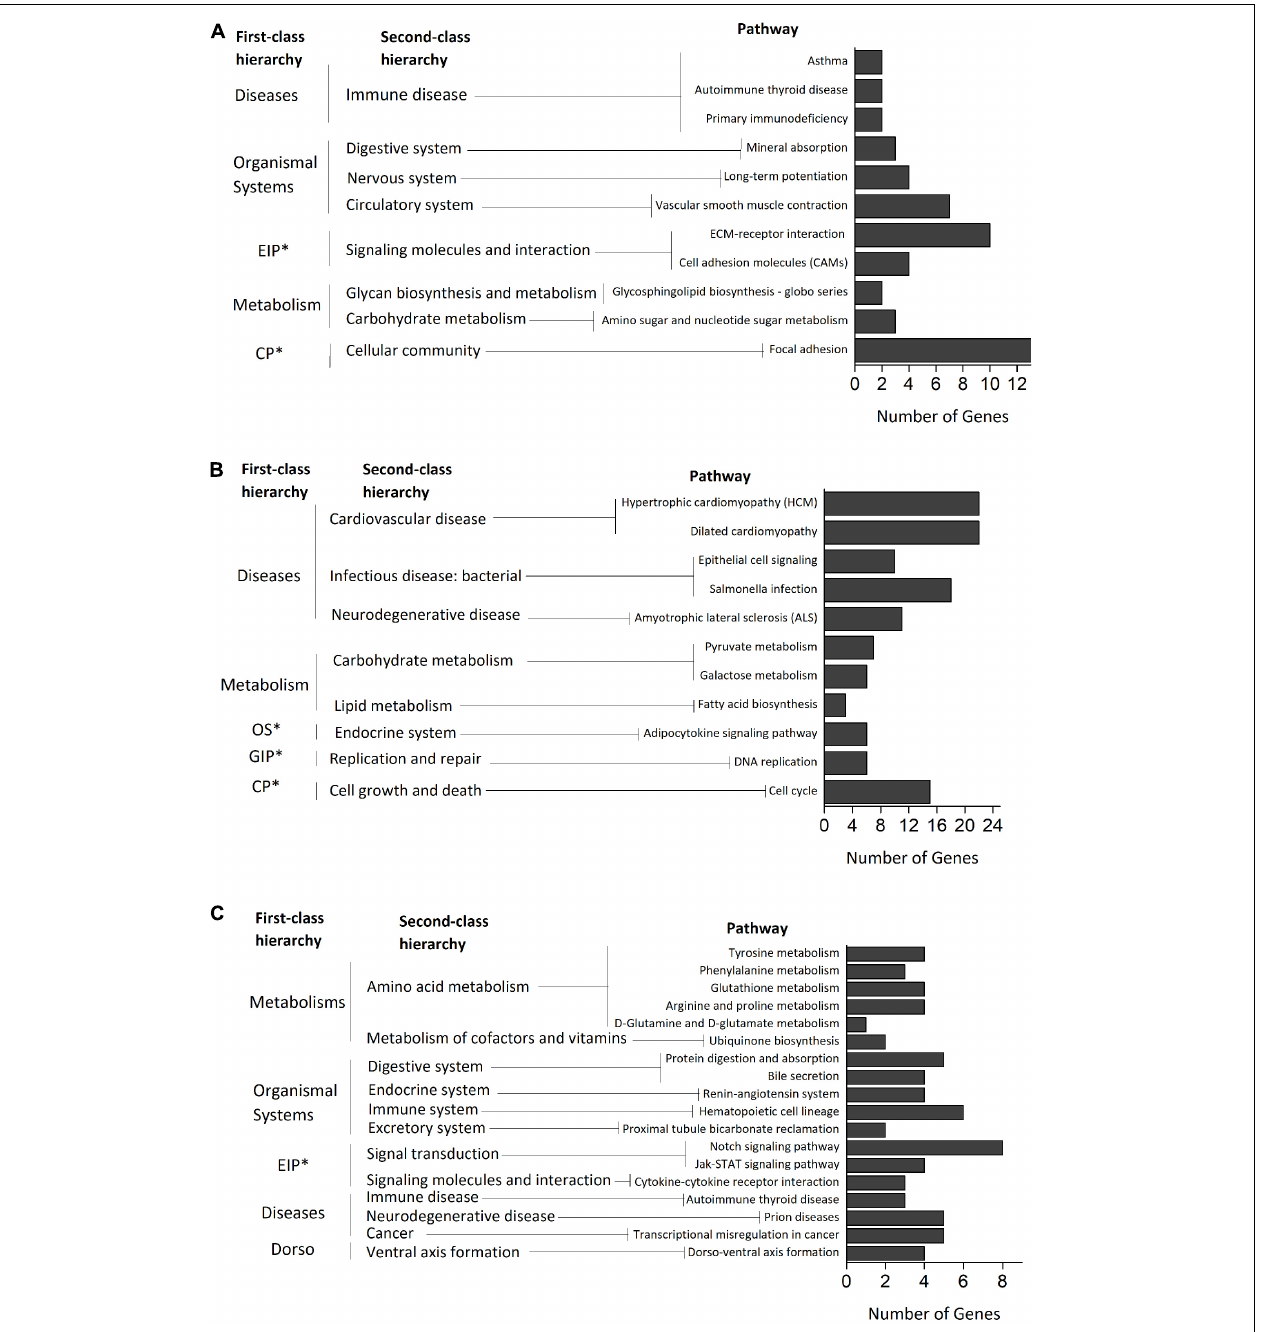
FIGURE 5 | KEGG pathway enrichment of the (A) ELD-J genes, (B) ELD-T genes, and (C) ELOD genes. *EIP, environmental information processing; CP, cellular processes; OS, organismal systems; GIP, genetic information